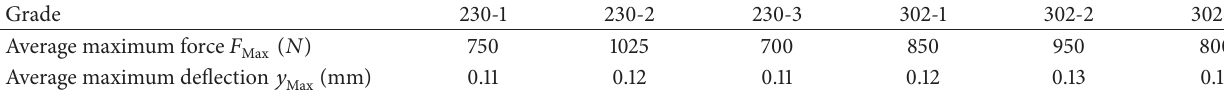
Table 2: Maximum force and deflection for the studied porcelain grades.